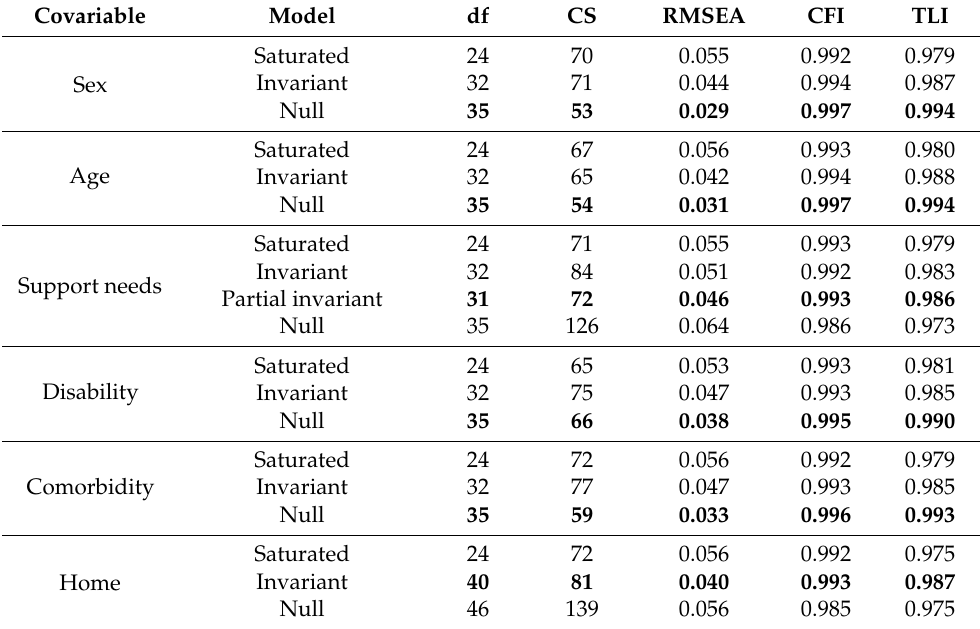
Table 4. MIMIC (multiple indicators-multiple causes) models.